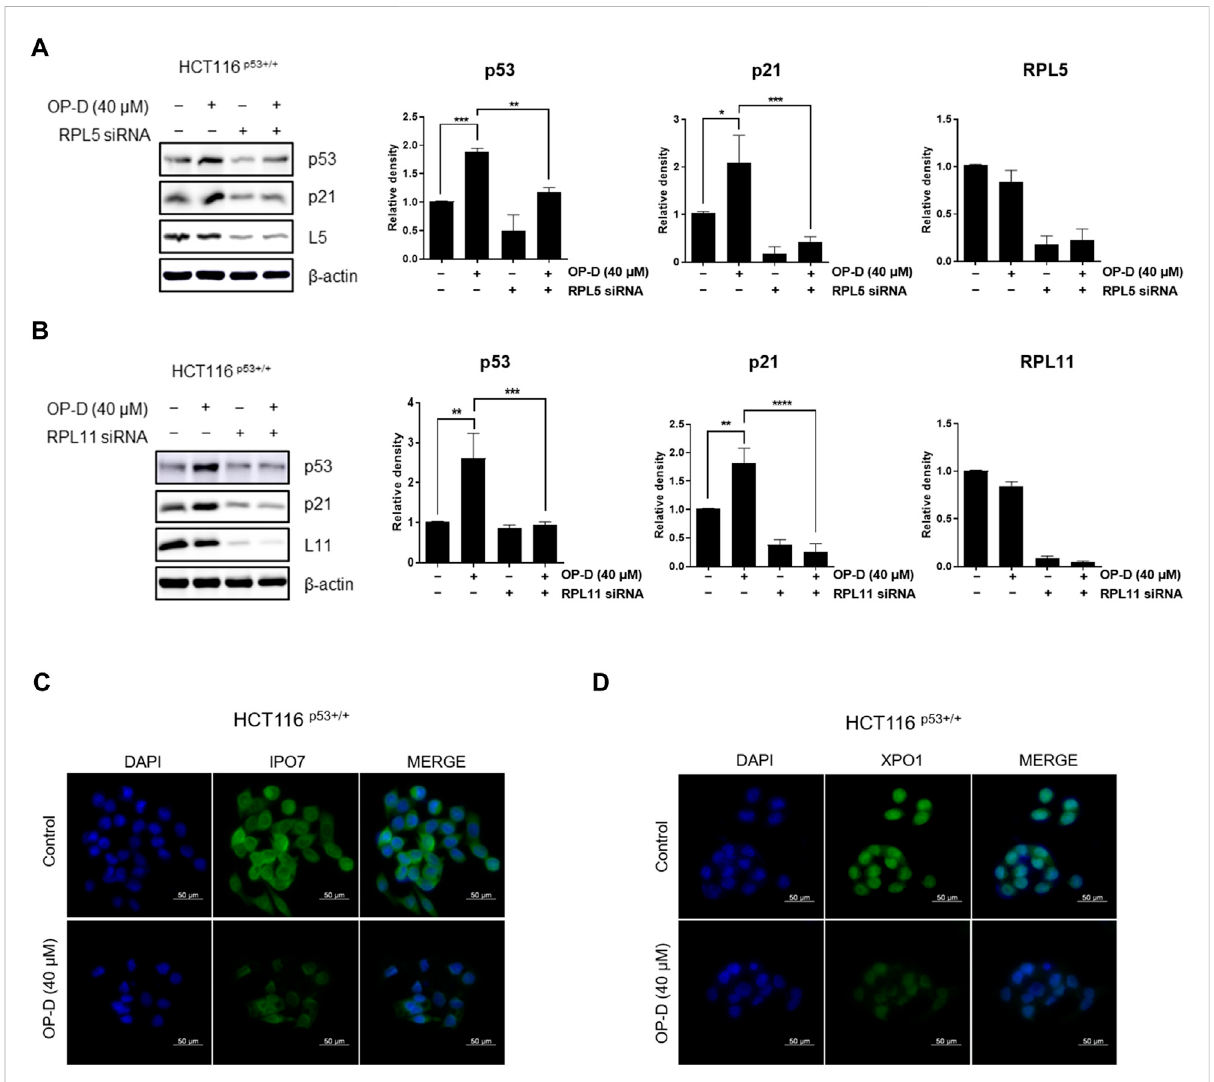
FIGURE 5 OP-Dactivatesp53 via RPL5orRPL11bycausingnucleolar stressinHCT116 p53+/+ cells. HCT116 p53+/+ cellsweretransfectedwith (A) L5or (B) L11 siRNAfor48h.Afterbeingtransfected,cellsweretreatedwithOP-D(40 μ M)duringfor24h.Celllysateswereperformedforp53,p21,L5,L11,and β - actin by Western blotting. Data represent means ± SD. * p < 0.05, ** p < 0.01, *** p < 0.005, **** p < 0.001. HCT116 p53+/+ cells were treated with OP-D (40 μ M) for 24 h. Then, cells were fi xed with 4% paraformaldehyde and stained with (C) IPO7 or (D) XPO1 antibody. Images are magni fi cation 400 ×, scale bar 50